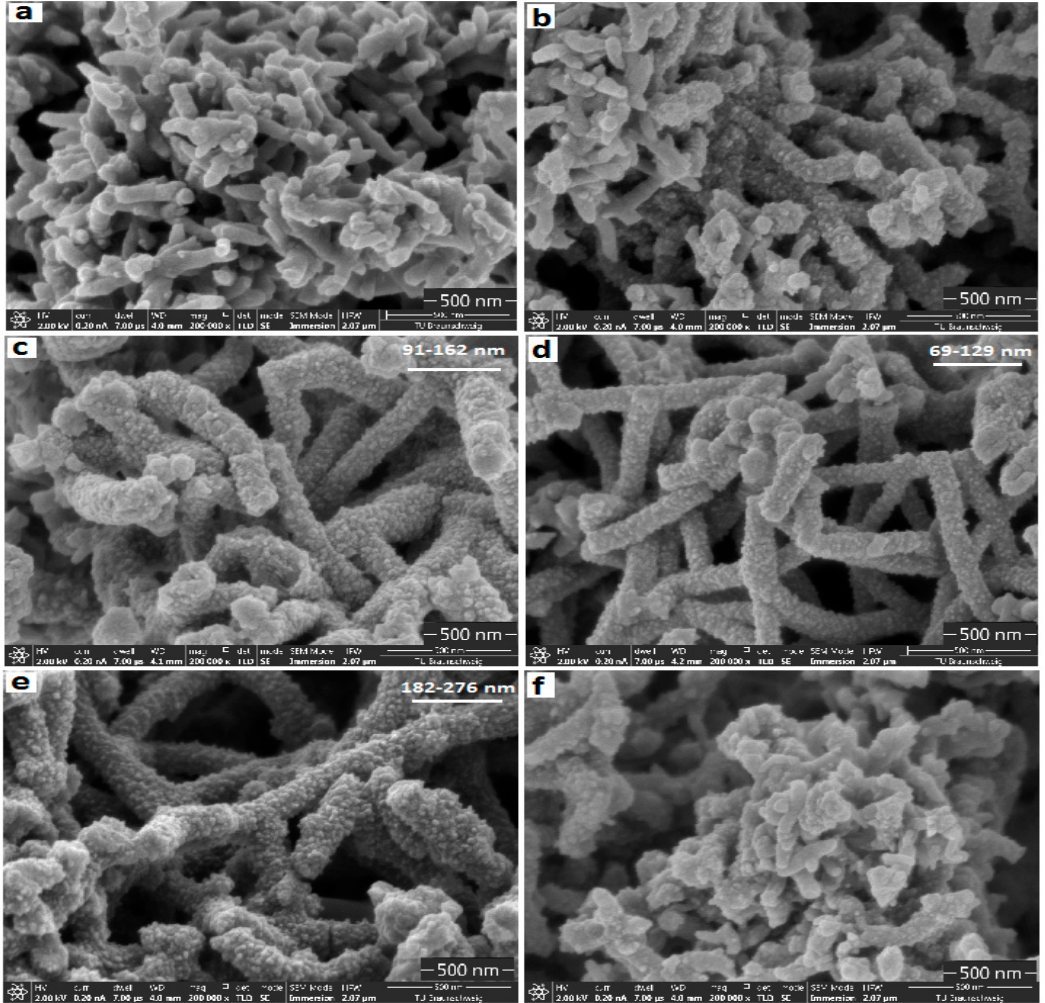
Figure 1. SEM pictures of the surface of PANI: ( a ) P-0.5PA, ( b ) P-1PA, ( c ) P-3PA, ( d ) P-5PA, ( e ) P-7PA, ( f ) P-10PA .